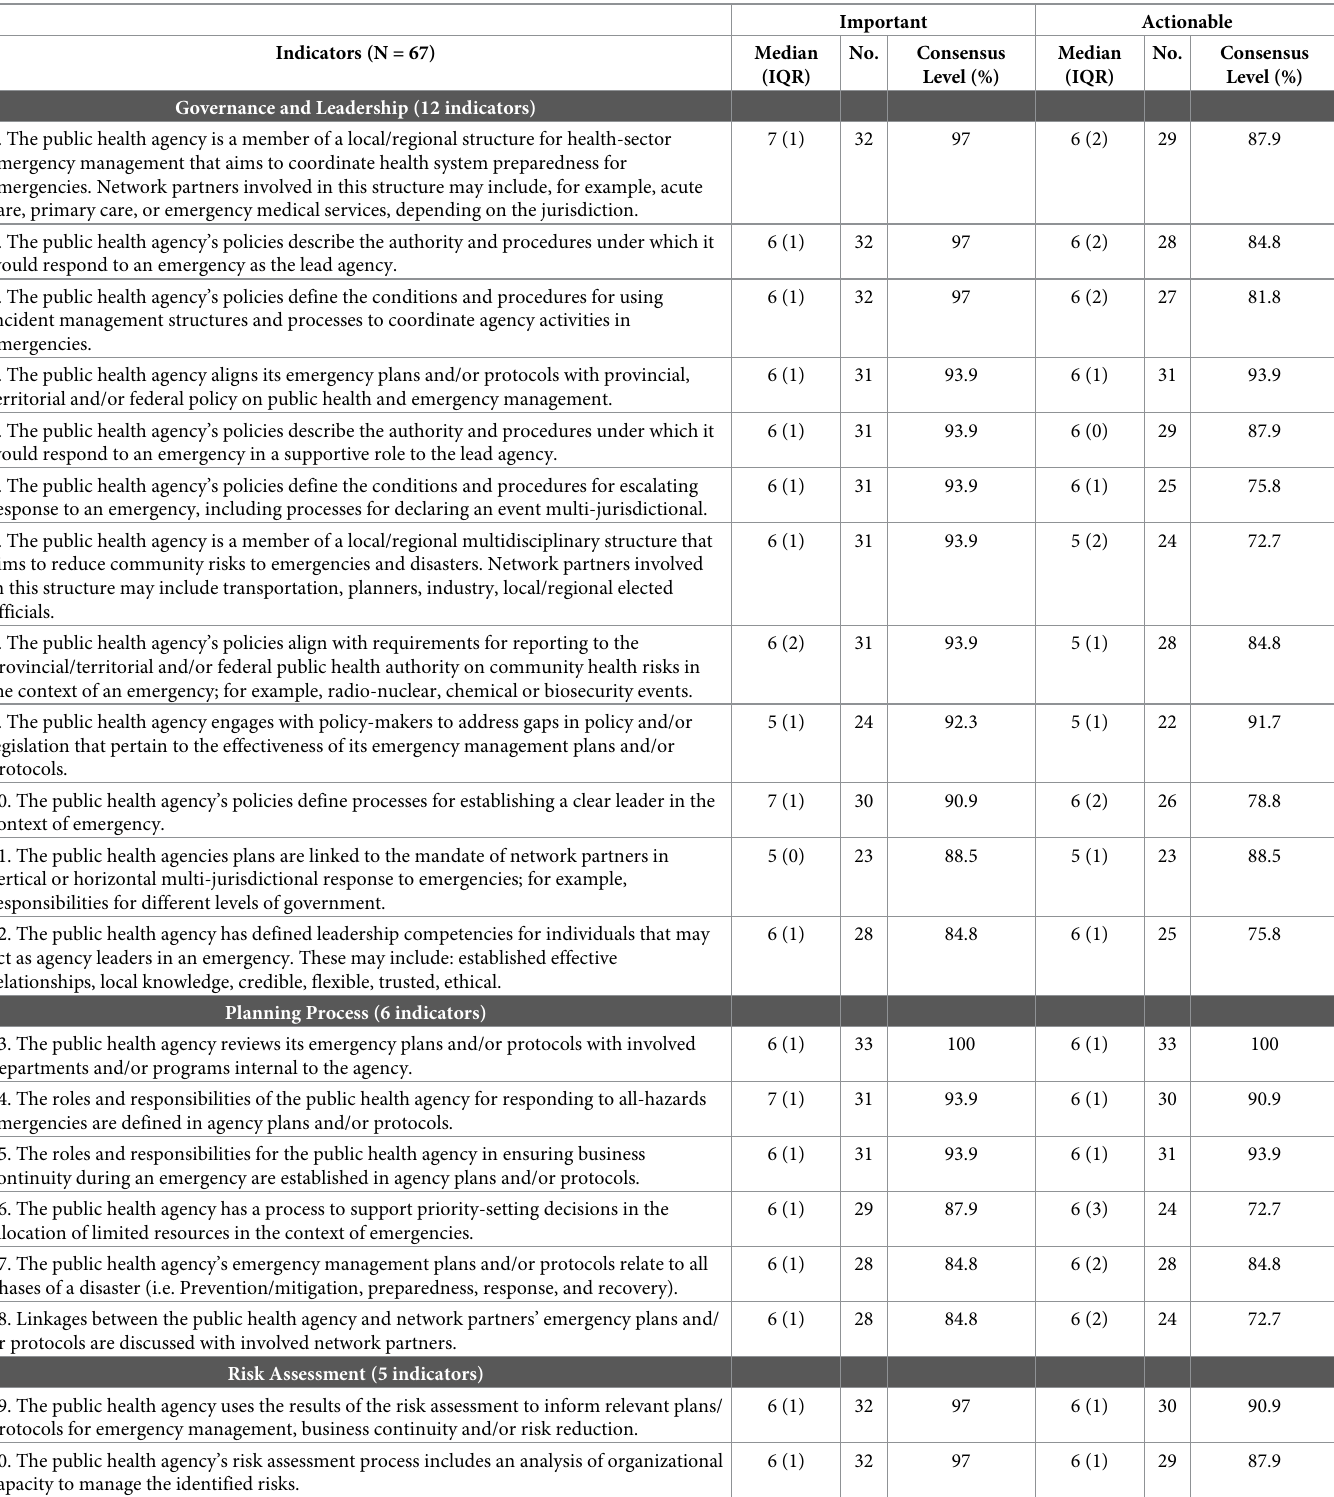
Table 3. Final set of public health emergency preparedness